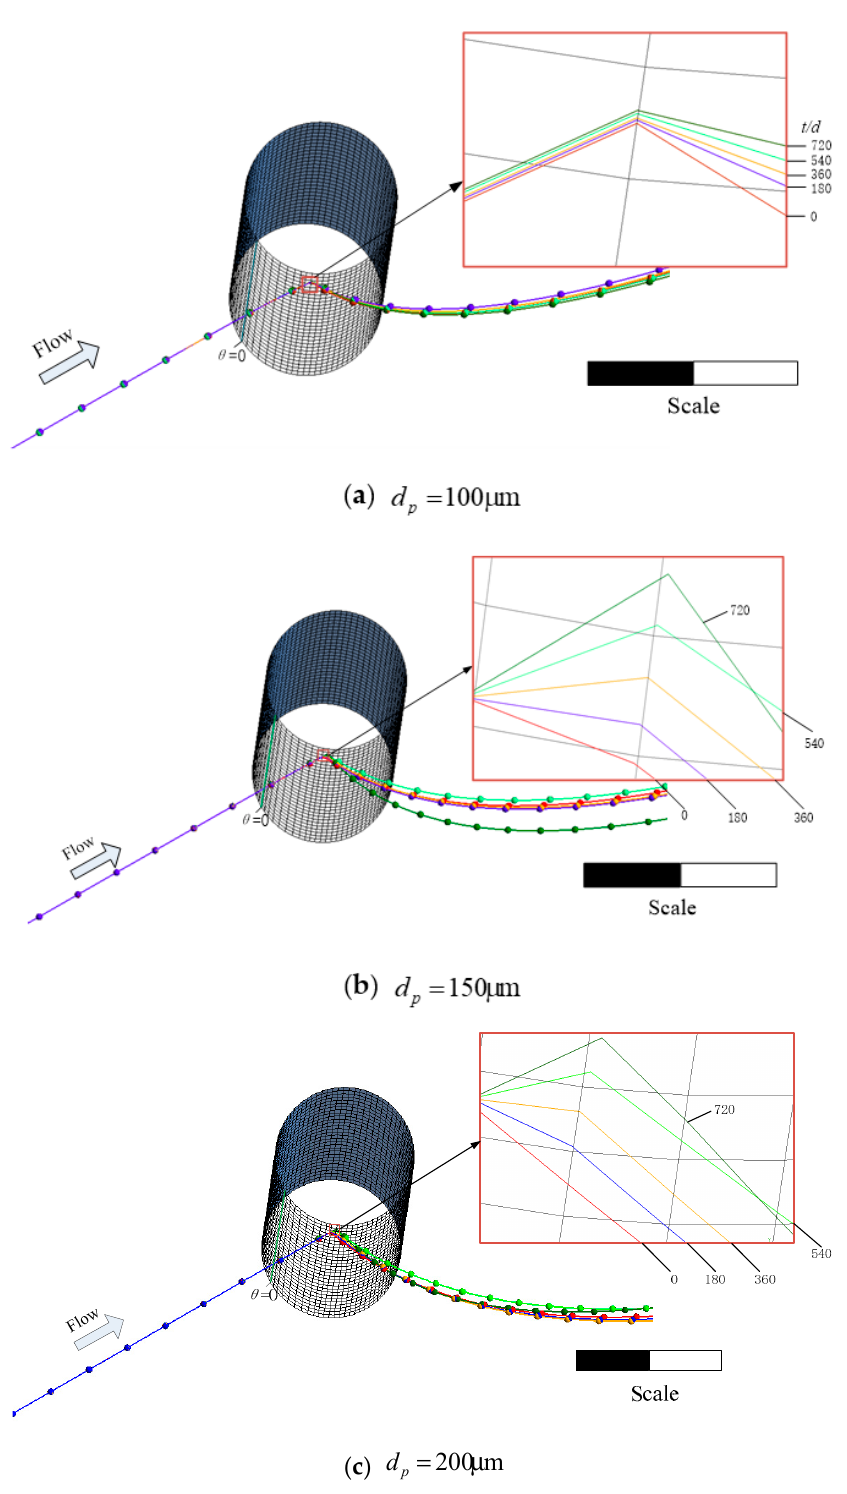
Figure 13. Particle